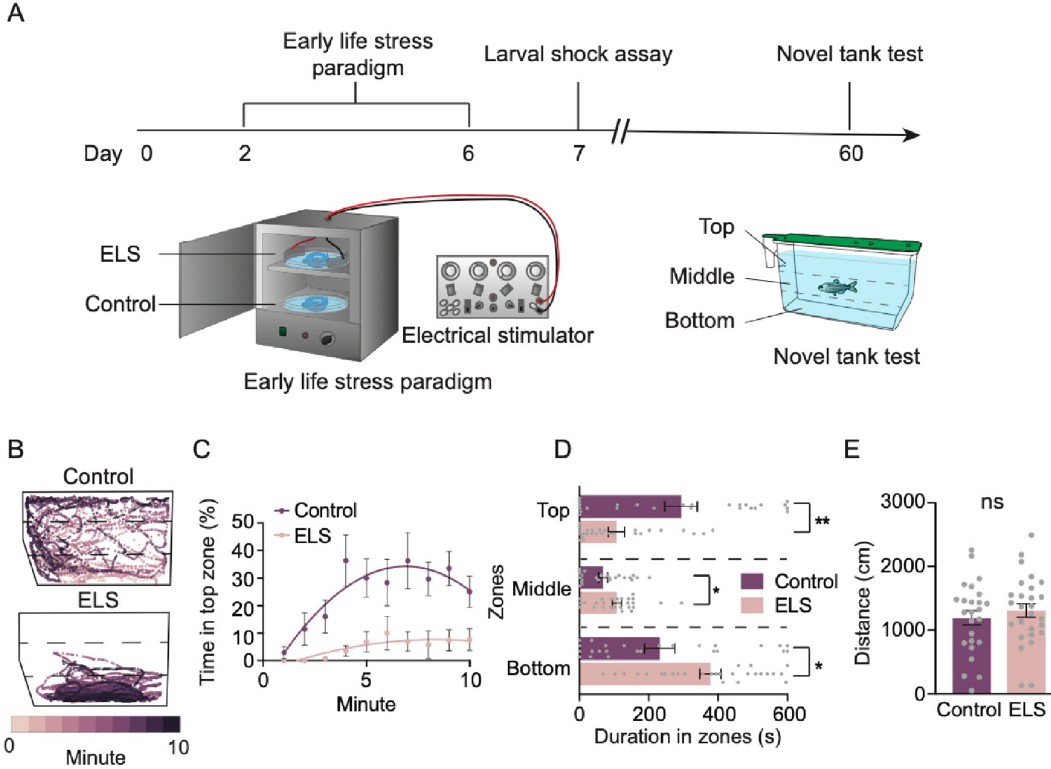
Figure 1. ELS results in exacerbated stress responses in adulthood. ( A ) Timeline of ELS and behavior experiments and illustrations of the ELS setup and novel tank test. ( B ) Representative swim trajectories of an individual control and ELS fish revealing that while control fish explored most of the tank, ELS fish swam more at the bottom of the tank. ( C ) Percentage of time spent in the top zone each minute throughout the 10-min recording. Over time, control animals gradually explored the top zone more frequently than ELS animals. ( D ) Compared to controls (n = 25), ELS adults (n = 27) spent less time exploring the top (Unpaired t test, p = 0.0003), and more time exploring the bottom (Unpaired t test, p = 0.0038) and middle (Unpaired t test, p = 0.018) zones. ( E ) Distances travelled were not different between controls (n = 25) and ELS (n = 27) animals (Unpaired t test, p = 0.46). Error bars show ± standard error of the mean. Asterisks denote statistical significance (*p = 0.05, **p = 0.005). ns denotes no